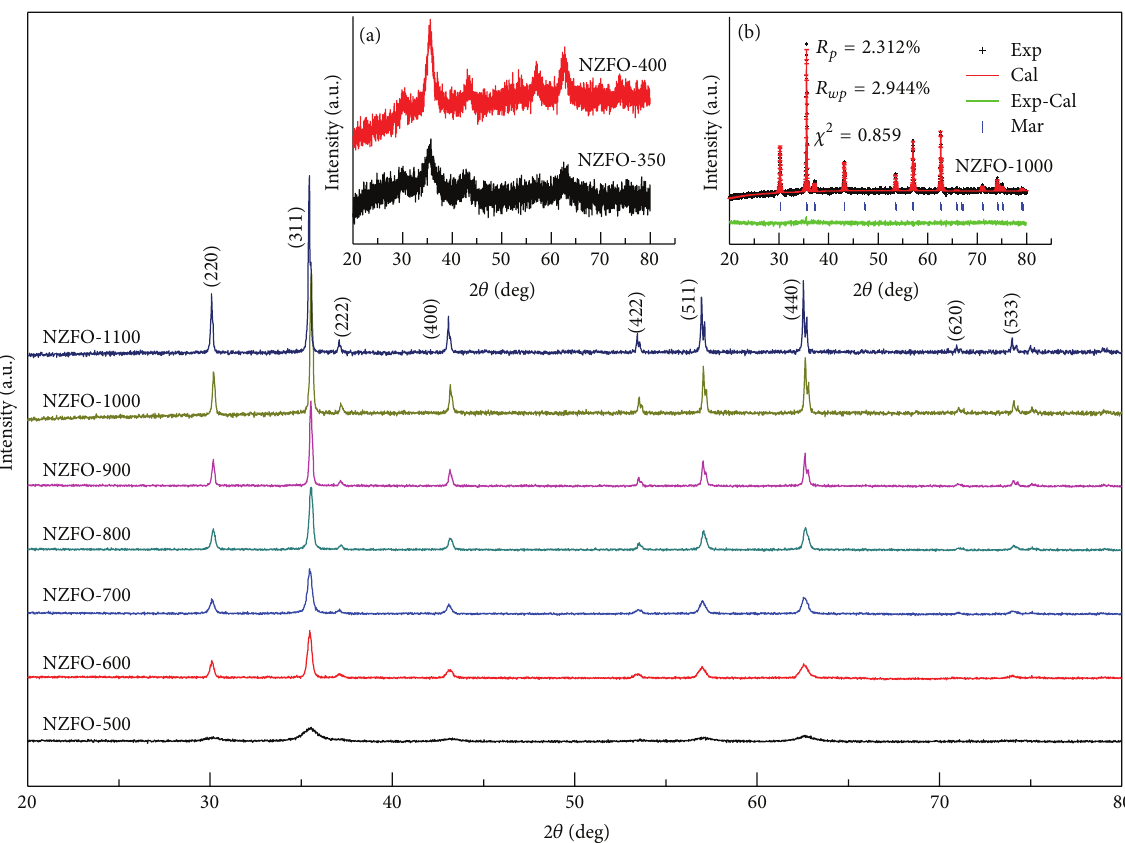
Figure 1: XRD patterns of Ni 0.5 Zn 0.5 Fe 2 O 4 at different annealing temperatures. Inset (a) shows XRD patterns of as-burnt powders and annealed at 400 ∘ C. Inset (b) is refinement result of XRD patterns for NZFO-1000. Table 1: Structural and magnetic parameters of Ni